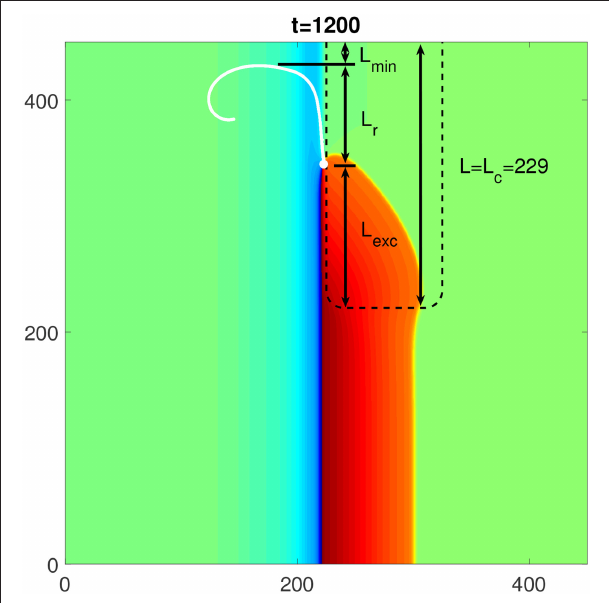
FIGURE 6 | Analogy between the non-penetration at the corner of a FIGURE 7 | The composition of the critical length L c of a rectangularly shaped rectangularly shaped FPR and the non-penetration of a circular wave into a FPR to initiate a rotor. The white dot and line are the initial location and the circular shaped FPR. (A) The non-penetration at the rounded corner of the following trajectory of the PCP, respectively. Three components of L c are: L min FPR (zoomed from Figure 2A ). (B) A circular wave blocked by the circular which describes the minimum distance of a persistent PCP from the top shaped FPR of the radius r 60. (C) The non-penetration boundaries for the medium boundary, L r which describes the vertical range of the PCP trajectory = rectangularly shaped FPR for R 15 (black dots) and for the circular wave and in the medium outside the FPR, and L exc which describes the propagation of = the circular shaped FPR with the radii r min 27.6 (red line) and r max 29.7 the penetrated excitation within the FPR. The FPR length L = = (blue line). (D) The dependence of 1 / r 1 / (2 R ) is proofed to be valid for a other parameters are the same as in Figure 1 = large range of R .